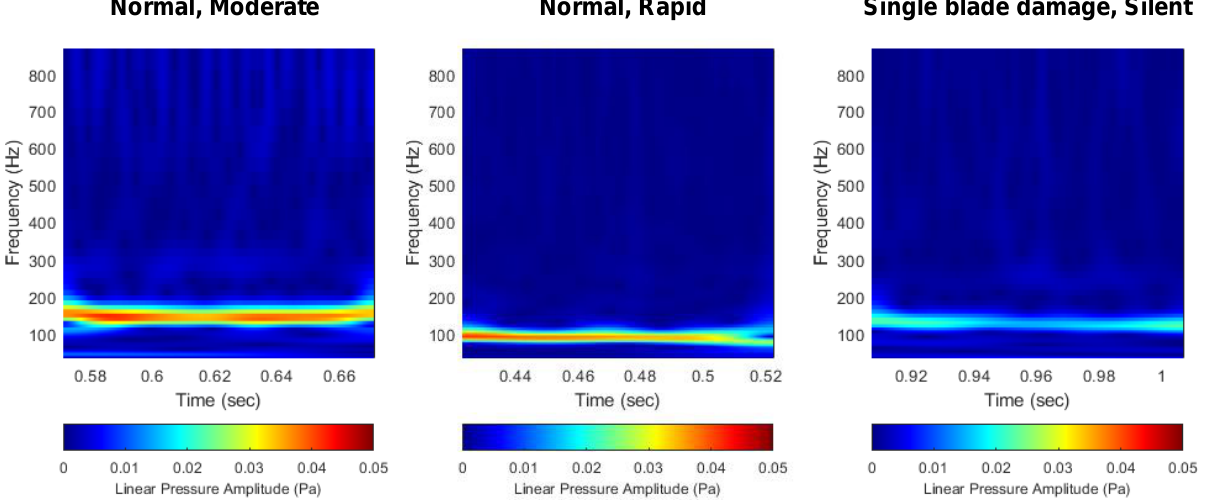
Figure 13. Flow noise scalogram for off-training condition with linear scale. ( left ) Normal–moderate; ( middle ) normal–rapid; ( right ) single-blade damage-silent.